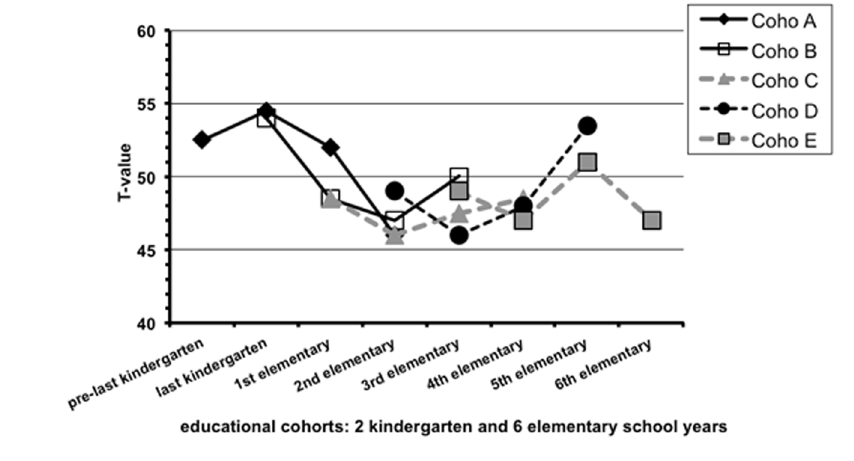
Figure 3. Cross-sequential results on self-esteem (SEL) in the Luxembourg sample.